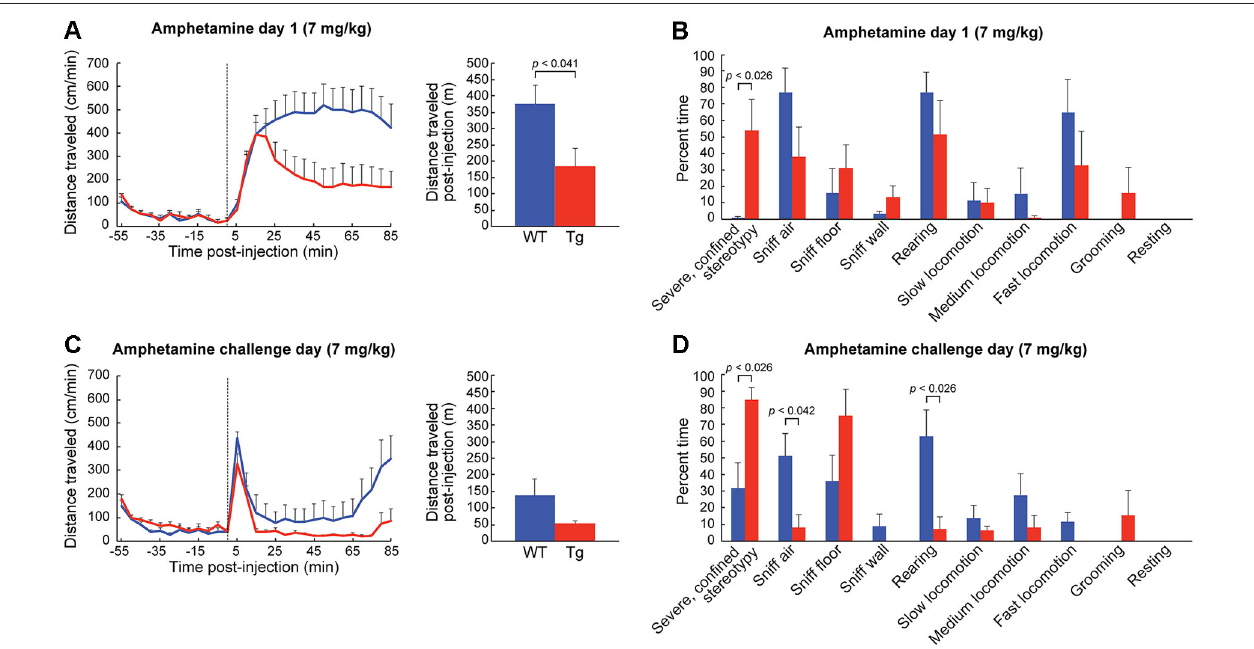
is significantly lower for the transgenic mice. (B) Observational rating of behaviors on day 1 showed a significant increase in severely confined stereotypies in transgenic mice relative to sibling controls. (C) Distance traveled measurements and (D) observational ratings on the challenge day of high-dose D-amphetamine